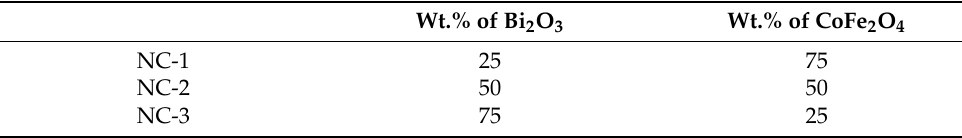
Table 4. Details of Bi 2 O 3 /CoFe 2 O 4